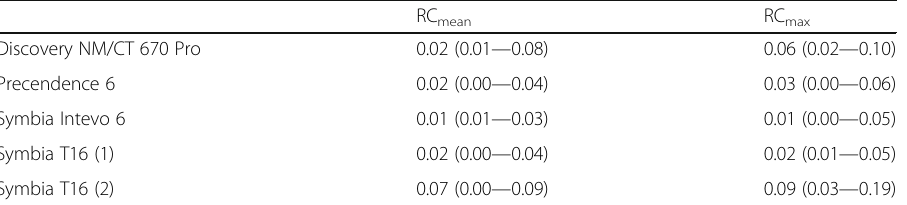
Table 5 MAD per system (median and range over all sphere diameters) for data reconstructed using a vendor and center-specific algorithm